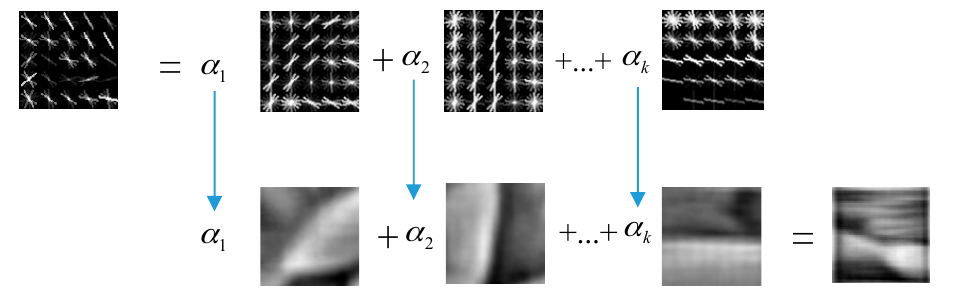
Figure 5. Process of the sparse representation of a dictionary pair.